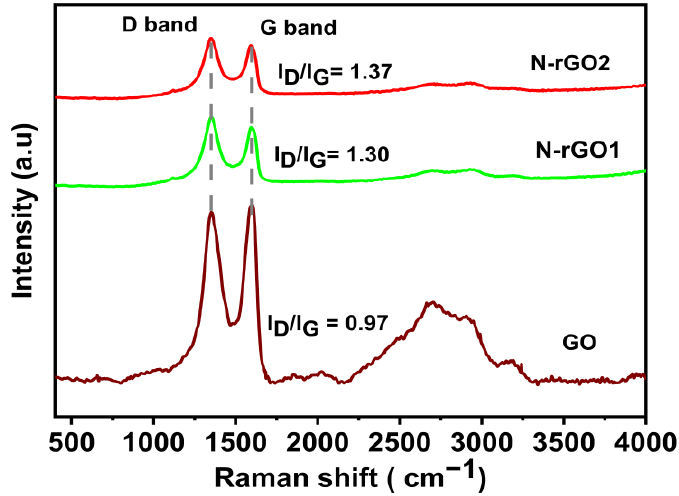
Figure 7. The Raman shift exhibited spectra of GO, N-rGO-1, and N-rGO-2.